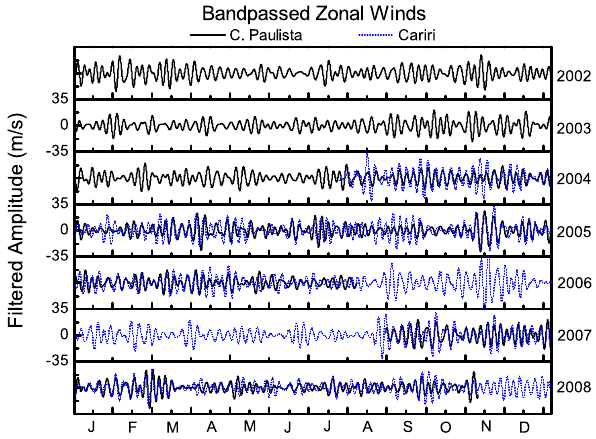
Figure 6. Band-passed hourly zonal winds over Cariri (blue dotted line), for the years 2004 to 2008, and over C. Paulista (solid black line), for the years 2002 to 2008, at 90km. The passband limit used Fig. 6. Bandpassed hourly zonal winds over Cariri (blue dot), for the years 2004 to 2008, and over C. Paulista (black line), for the years 2002 was 4.5 to 8.5 days, centered on 6.5 to 2008, at 90 km. The pass-band limit used was 4.5 to 8.5 days, centered on 6.5 days.